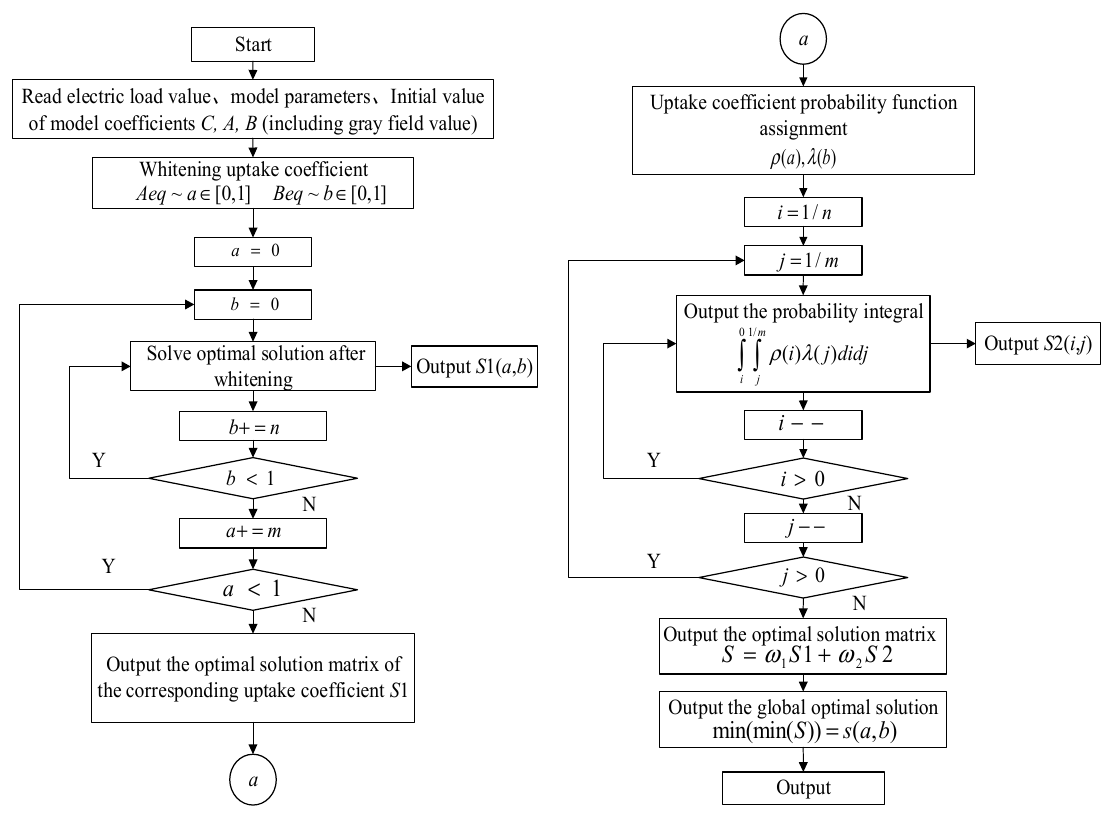
Figure 2. Economic operation using the grey multi-objective linear programming model. Step 1: Initialization. Whiten the optimal solution matrix. Whiten the probability in- tegral matrix, which is a [1/ n , 1/ m ] order zero matrix. Obtain the technical parameters of the power generation and energy storage modules. Obtain the model constraint matrices A and Aeq , and the thermal and electric load values, and obtain the model constraint ma- trices B and Beq . If the parameters are in the variable range, the corresponding coefficient matrix is represented by the corresponding grey field value. Step 2: Whiten the grey coefficient in the model, and set the corresponding whitening uptake coefficients